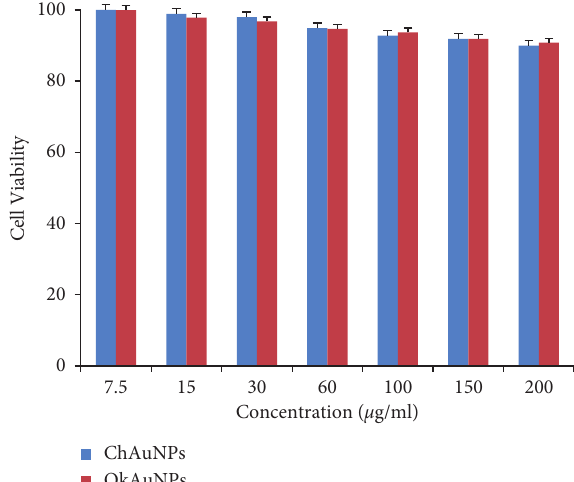
Figure 8: Cell viability of Ch Au NPs and Ok Au NPs on HDF cells after 24h incubation at different concentrations (0, 7.5,15, 30, 60, 100, 150, and 200 μ